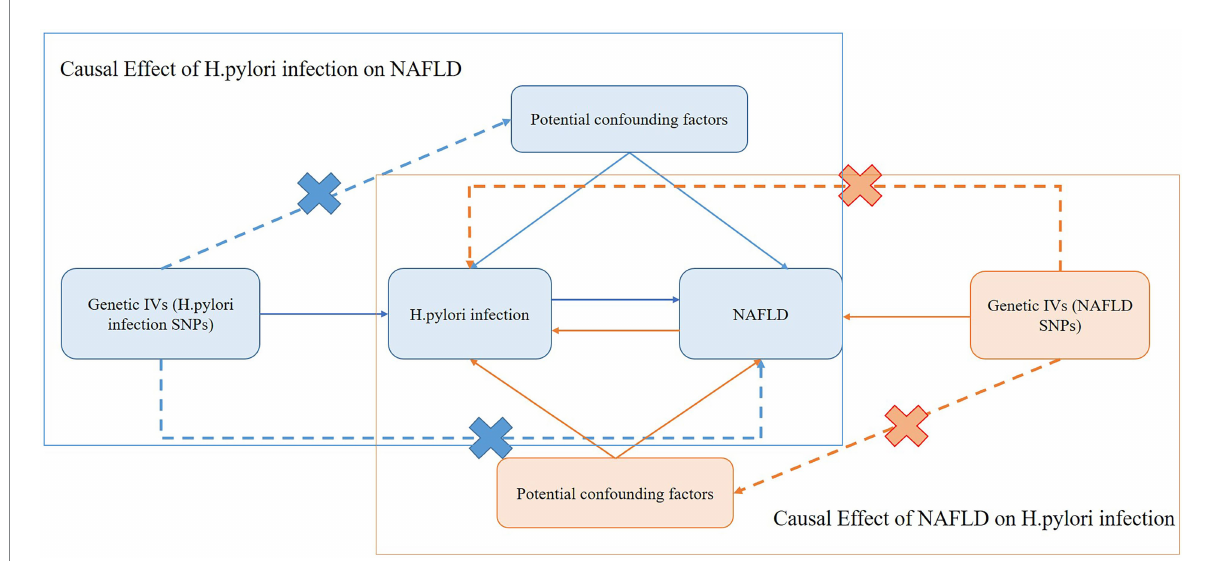
FIGURE 1 Schematic representation of the bidirectional MR study on the causal relationship between H. pylori infection and NAFLD. IVs, instrument variants; H. pylori , Helicobacter pylori ; SNP, single-nucleotide polymorphisms; NAFLD, nonalcoholic fatty liver disease.